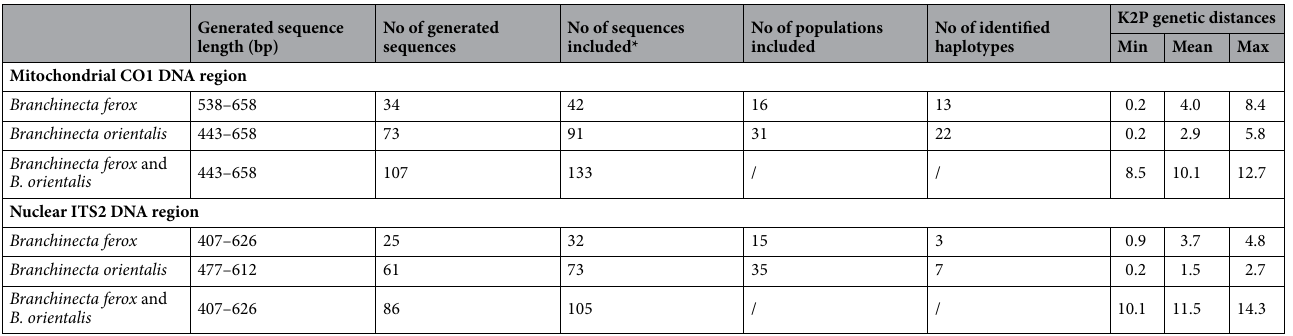
Table 1. Kimura 2-parameter genetic distances with partial deletion of 90% for both Branchinecta species and two genetic markers, mitochondrial CO1 and nuclear ITS2 DNA regions. *Additional sequences were downloaded from GenBank (MW829405-MW829407 47 , LT821325-LT821341 89 and LC469606 96 ). For more details on produced sequences and studied populations, see Table A1 in the Appendix